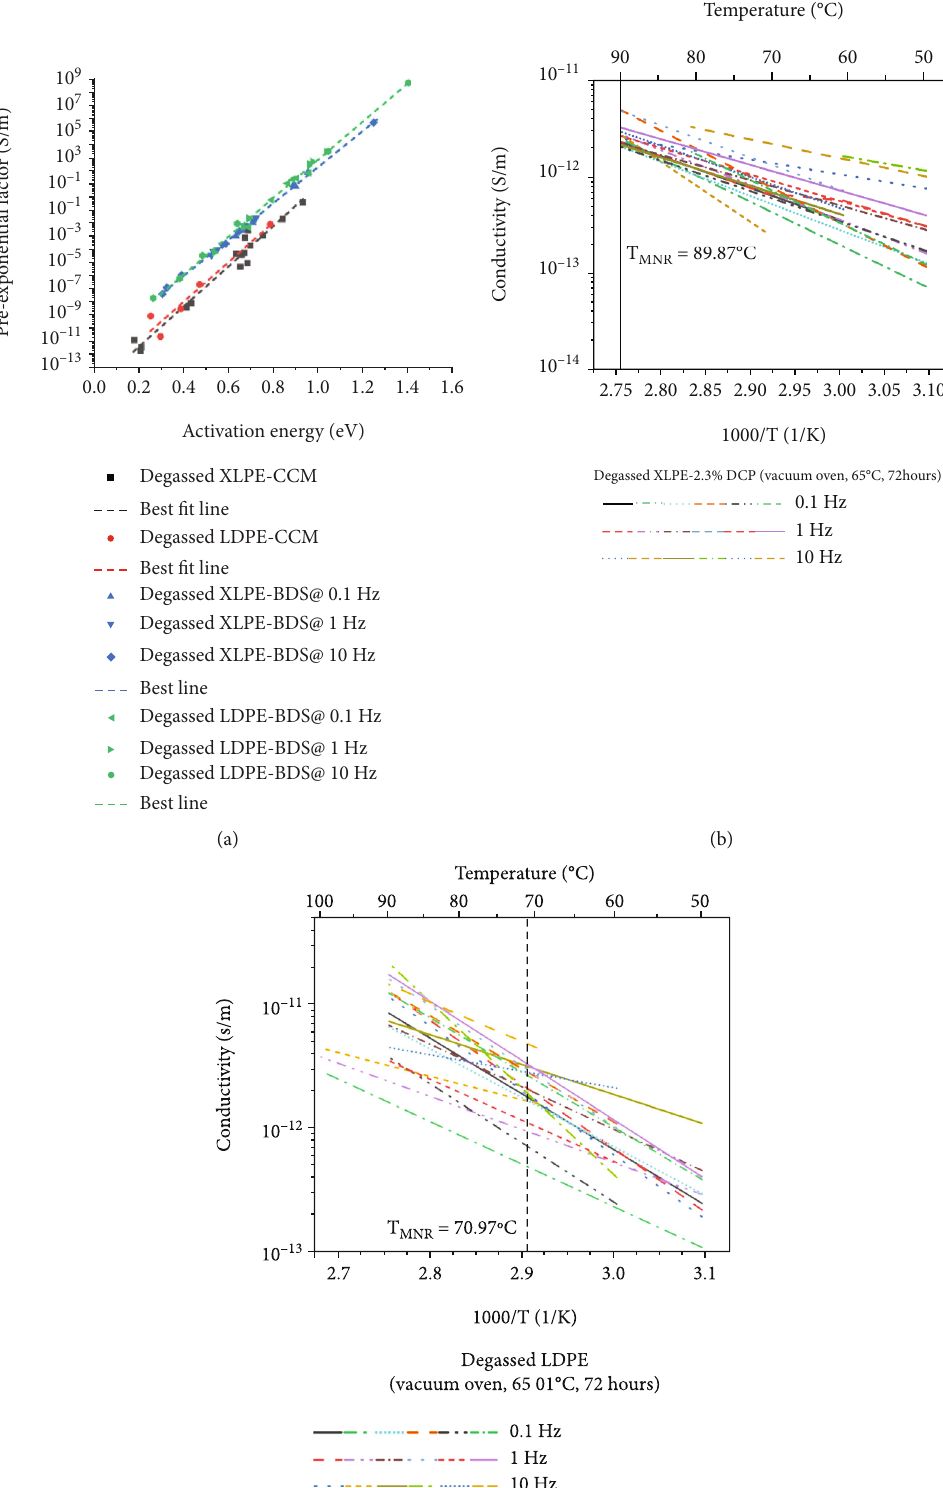
Figure 5: (a) Compensation law plots for degassed XLPE and degassed LDPE comparing the DC and AC results. (b, c) The corresponding conductivity vs. temperature data for the AC measurements for XLPE (b) and LDPE